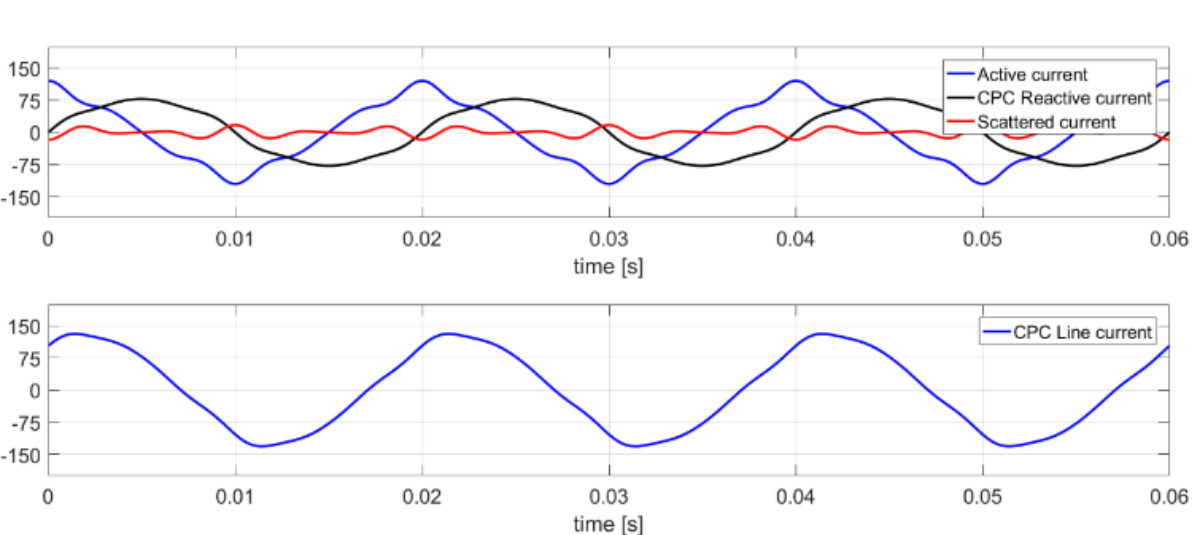
Figure 6. The waveform of the currents’ components and current of the load in developed Bude- anu’s theory. From the presented calculations from the Theoretical Illustration no. 1, it can be no- ticed that the waveforms of the load current, presented in Figures 4–6, are identical. It is also worth paying attention to the character of reactive power presented in Table 3. The reactive power for ea ch harmonic is inductive, so it cannot be mitigated by the value of the reactive power of harmonics of different orders. Despite this, Czarnecki ’s reactive cur- rent has a different RMS value and a different CRMS value than the Budeanu reactive current.